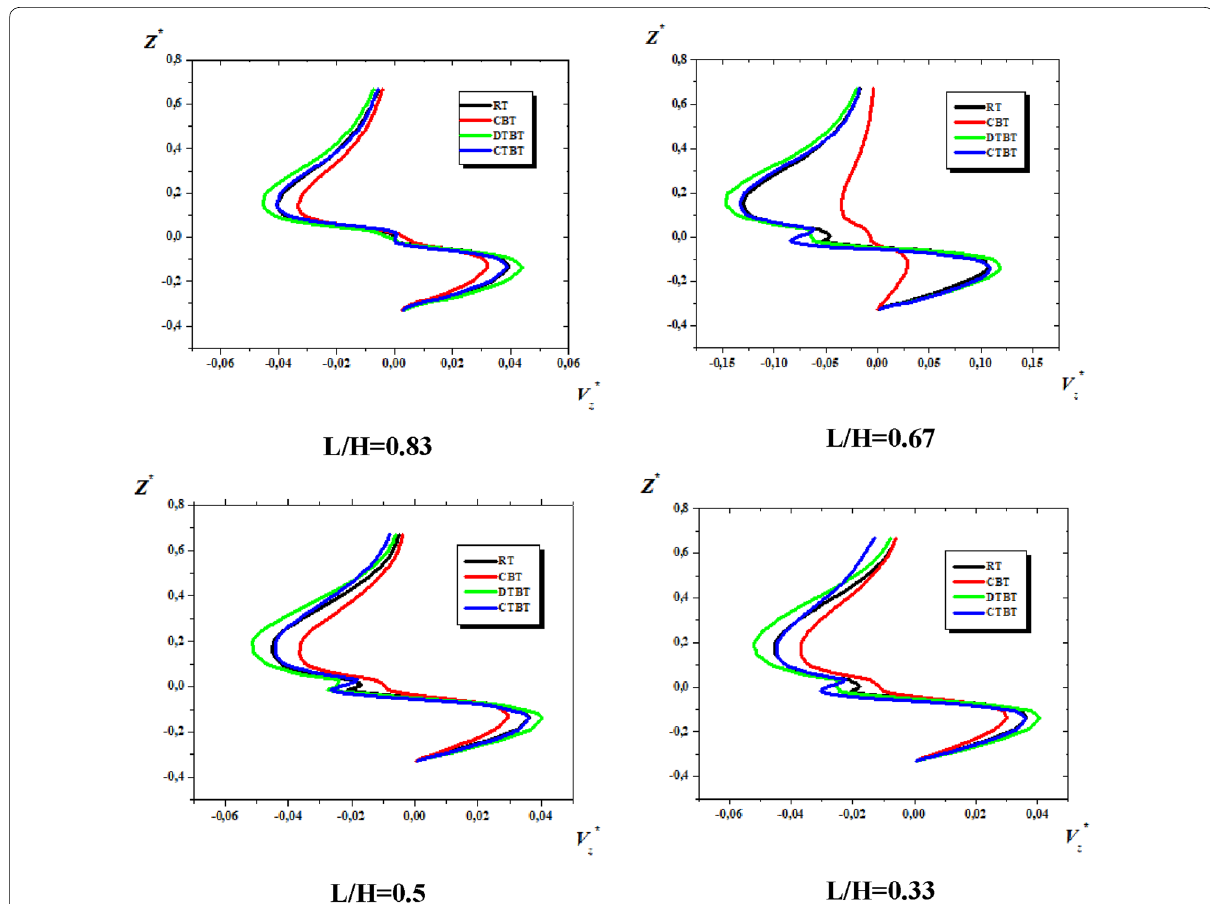
Figure 13 Axial velocities for different agitator’s types with various baffles heights along the vessel radius, at R *